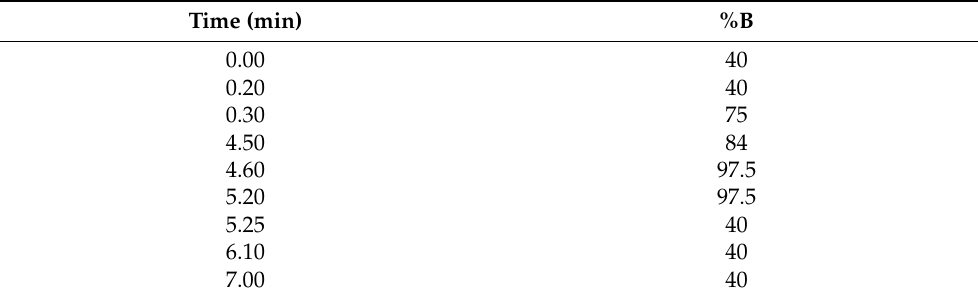
Table 1. Binary flow gradient for the 25-OH vitamin D3 analysis. A flow rate of 0.4 mL/min was maintained throughout the analysis.